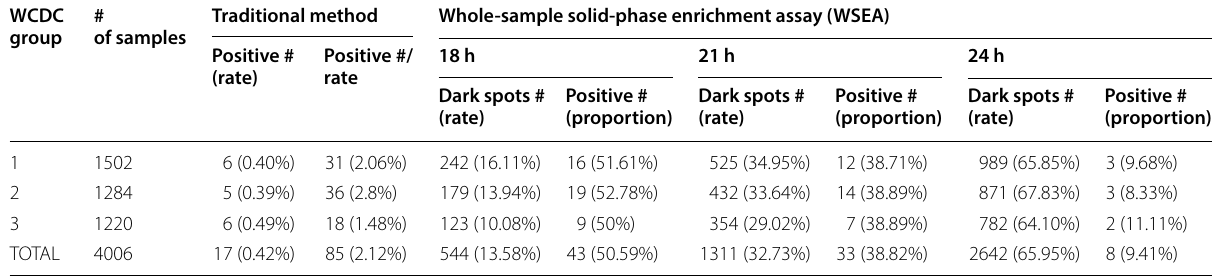
Table 5 Statistic comparison of traditional method and WSEA on human feces samples WCDC # group of